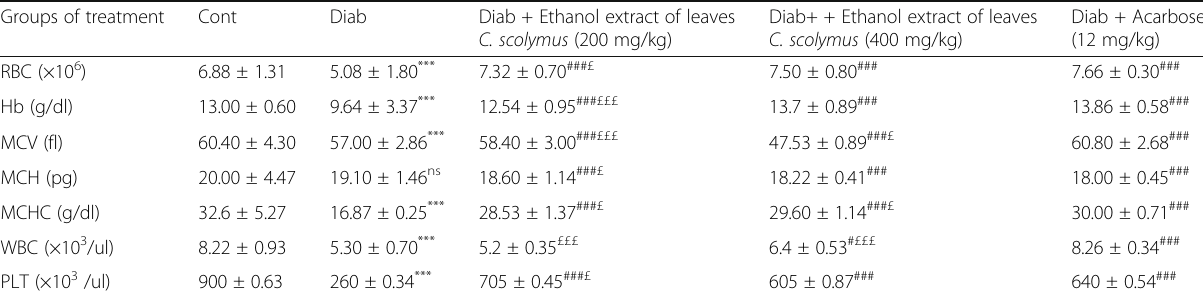
Diabetic rats were orally administered with the ethanol extract from leaves of C. scolymus and acarbose at the doses mentioned earlier for 28 days. Values are given as means ± SD ( n = 8). *** p ≤ 0.001 were considered significant compared to control group; # p ≤ 0.05, ### p ≤ 0.001 were considered significant compared